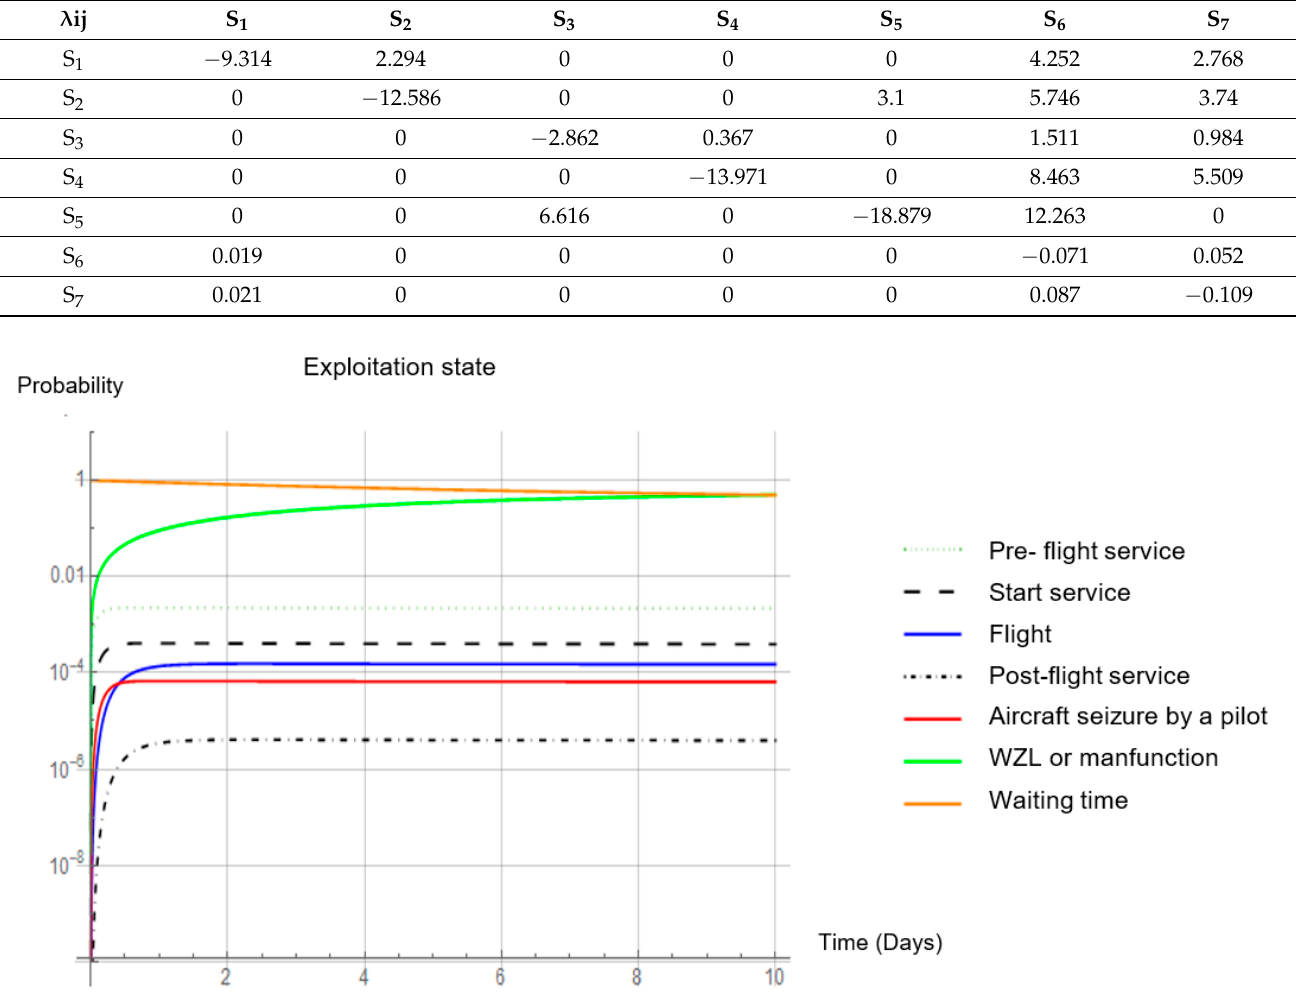
Figure 3. The possibility of aircraft being in all exploitation states; average values for the whole group of objects (own study).